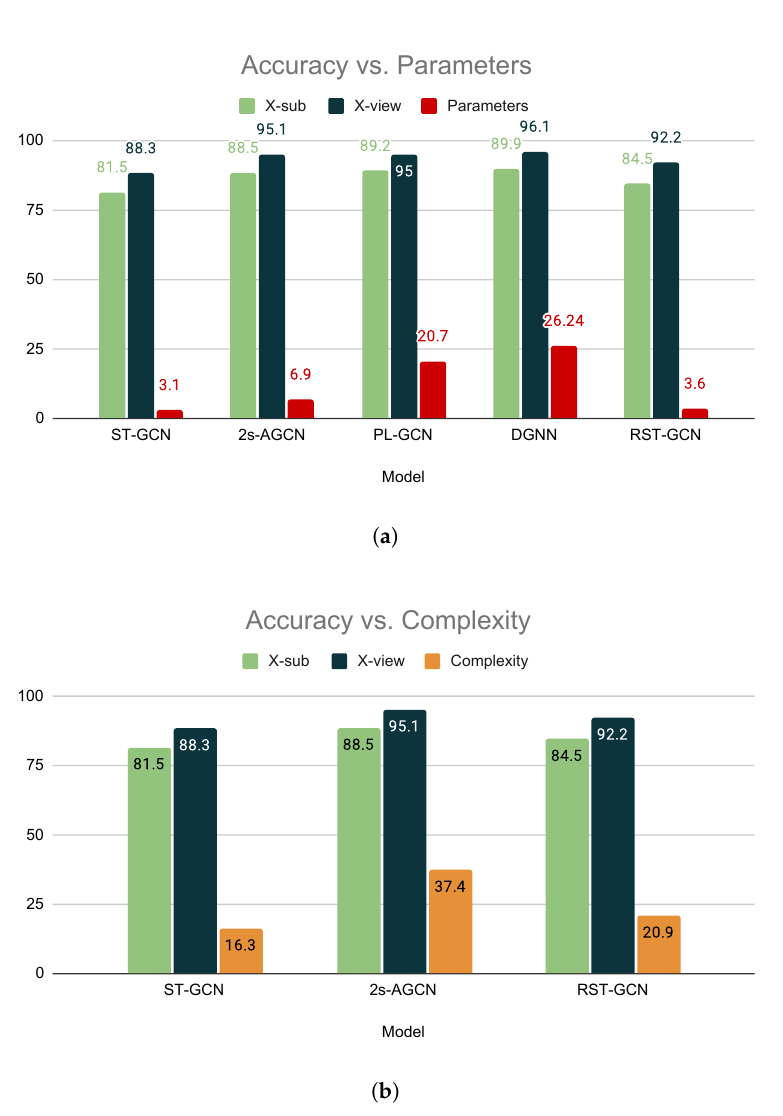
Figure 9. Comparisons between STGCN and other GCN-based models. ( a ) Comparison between STGCN and other GCN-based models with respect to the number of parameters. ( b ) Comparison between STGCN and other GCN-based models with respect to